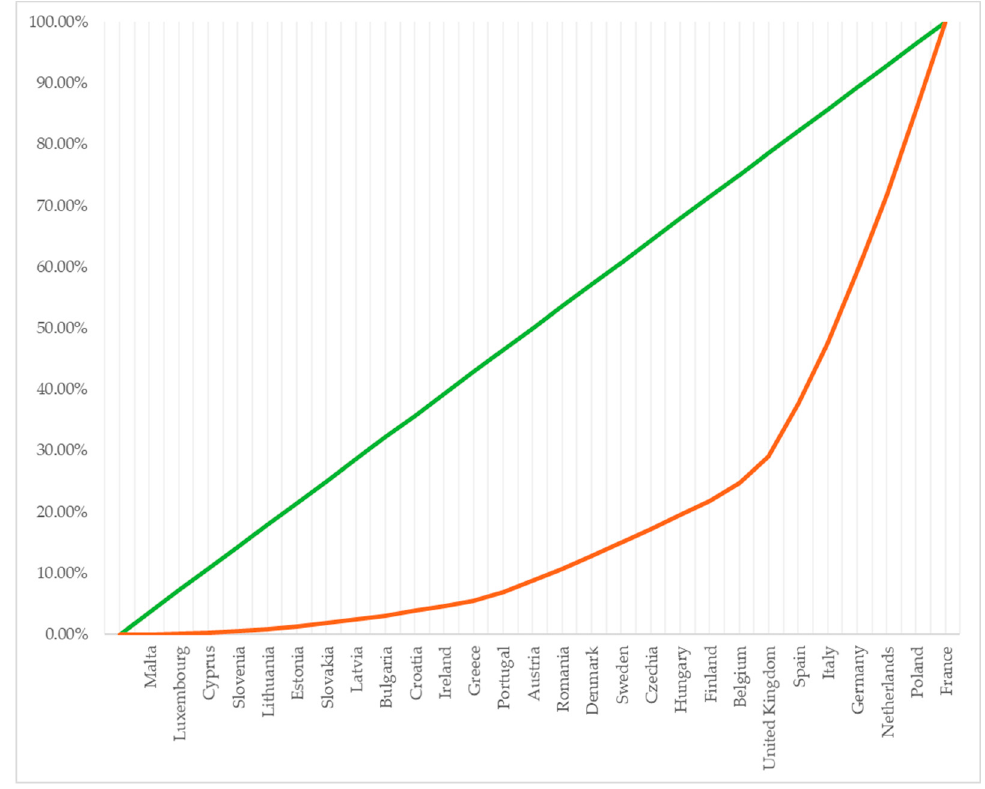
Figure 2. The concentration of energy consumption in agriculture in 2018. Reproduced from [42], Eurostat: 2021.